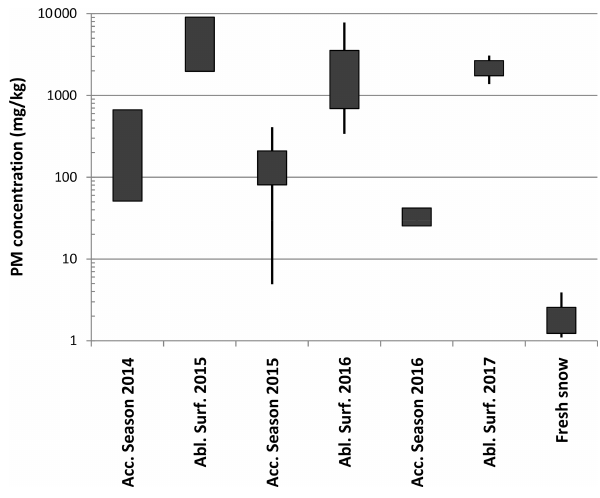
Figure 5. Seasonal range of PM concentration found on snow and firn samples. For accumulation season, the values represent the mean PM concentration in thick, low-PM layers of snow and firn. For ablation season the values represents the surface PM concen- tration at the end of the season. The box encompasses 1 standard deviation of data, and whiskers represent minimum and maximum values (when N > 2). Notice that for seasonal layers with only two measurements, the box represents those two values (coincident with the definition of standard deviation for N = 2). The plot includes data from both field campaigns and excludes ablation ice samples, which cannot be assigned to a specific year or season. Fresh snow represents snow that fell a few days before the field campaigns of 2016 or